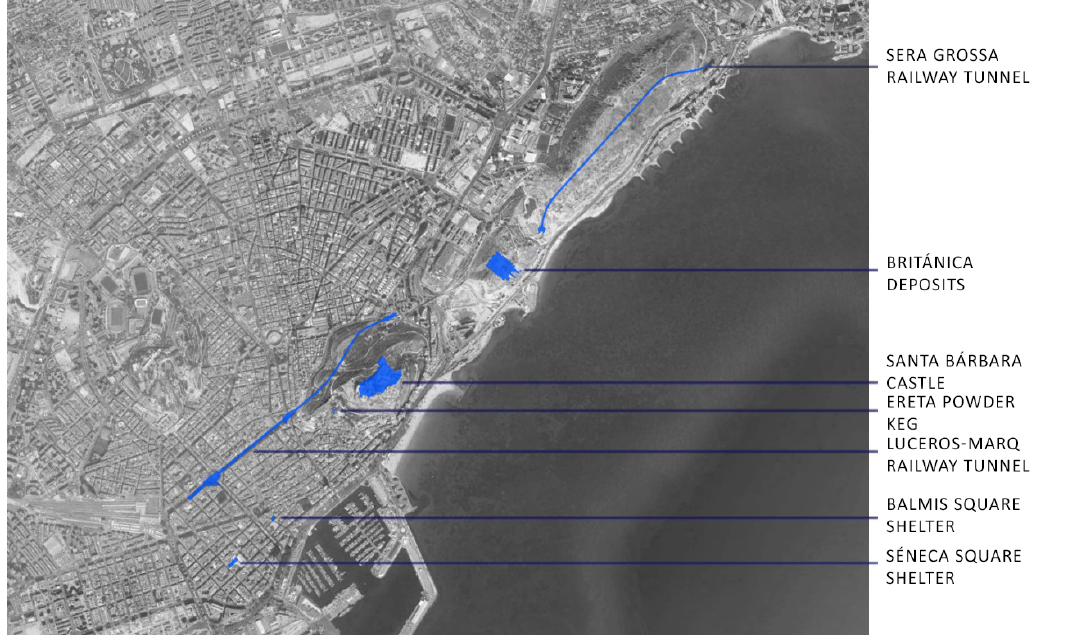
Figure 1. Image of the different enclaves chosen in the study of the city of Alicante: the shelters of Plaza Balmis and Plaza Seneca, the Castle of Santa Barbara, the Powder Magazine of the Ereta, the deposits of the British and the two tunnels of the TRAM of Alicante (Source Google Maps . Own